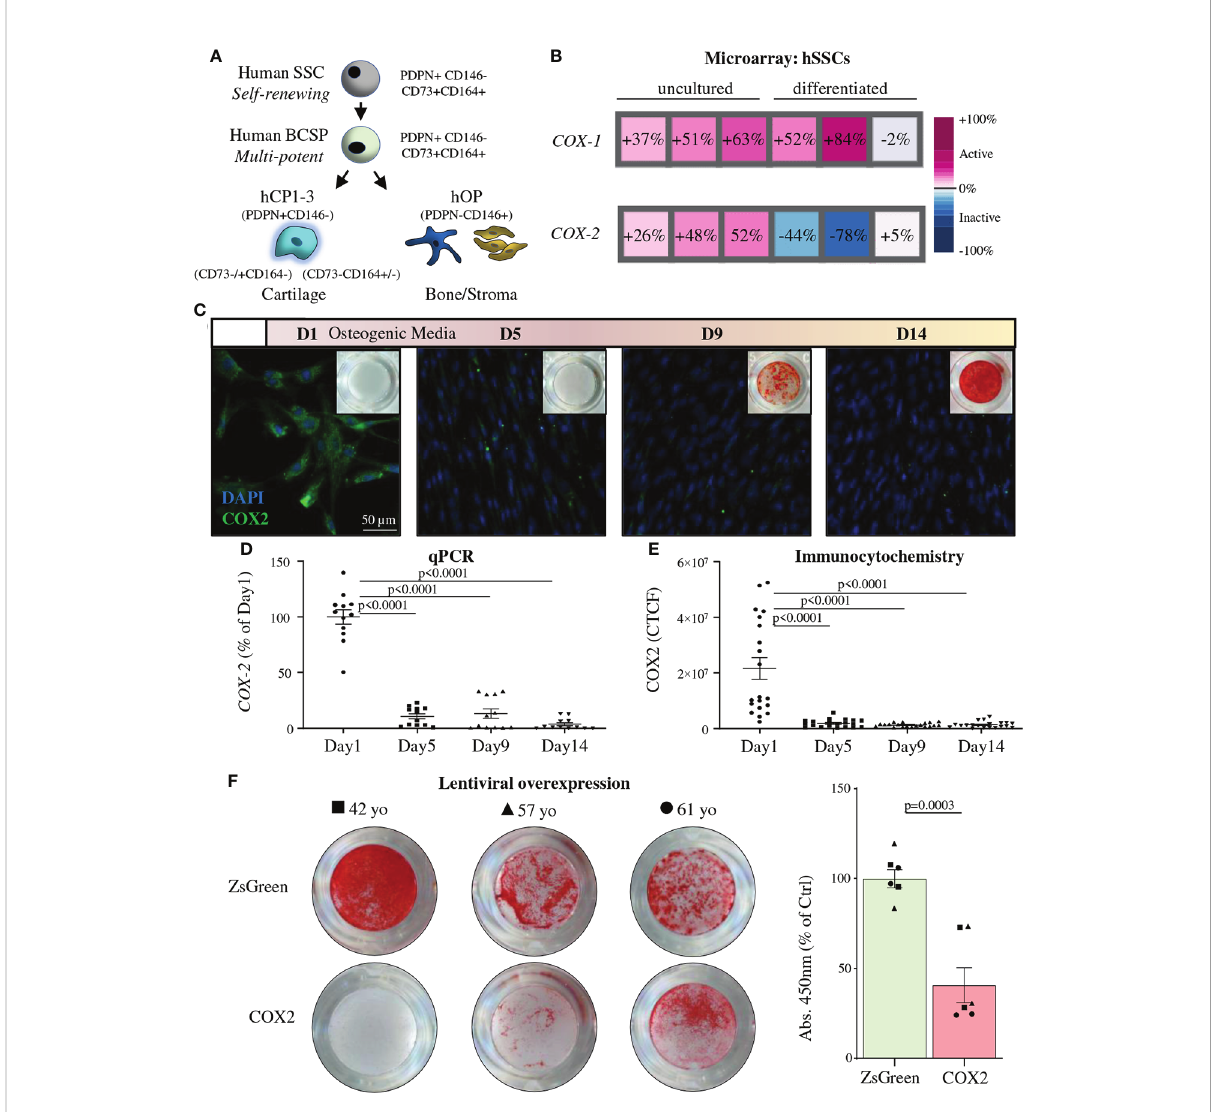
FIGURE 2 COX2 downregulation is necessary for osteogenic differentiation of human SSCs. (A) The human skeletal stem cell (hSSC) lineage tree as de fi ned by surface marker expression pro fi les with the hSSC at the apex and the downstream bone cartilage stroma progenitor (hBCSP) which gives rise to committed bone (hOP) and cartilage (hCPs) progenitor cells. (B) Microarray analysis showing COX-1 and COX-2 expression of freshly puri fi ed (uncultured) hSSCs from human fracture callus tissue of three different patients as well as their expression after two-week osteogenic differentiation from hSSCs. (C) Representative IHC images of COX2 staining in freshly puri fi ed hSSCs at different timepoints during in vitro osteogenesis. (D) Related quantitative PCR of COX-2 expression in the same experiment. n=12 independent replicates of hSSCs from four patients performed in triplicates. (E) Quanti fi cation of COX2 ICC staining by CTCF (corrected total cell fl uorescence). n=20 independent replicates of hSSCs from two patients (n=10 each). Statistical testing between timepoints by one-way ANOVA with Tukey ’ s posthoc test. (F) Alizarin Red staining and quanti fi cation of hSSCs (with patient age; yo: years old) of lentivirally overexpressed COX2 or ZsGreen controls during osteogenic differentiation. n=6 independent replicates of hSSCs from three patients performed in duplicate. Statistical testing by unpaired Student ’ s t-test. All data shown as mean ± SEM. All results from at least two independent